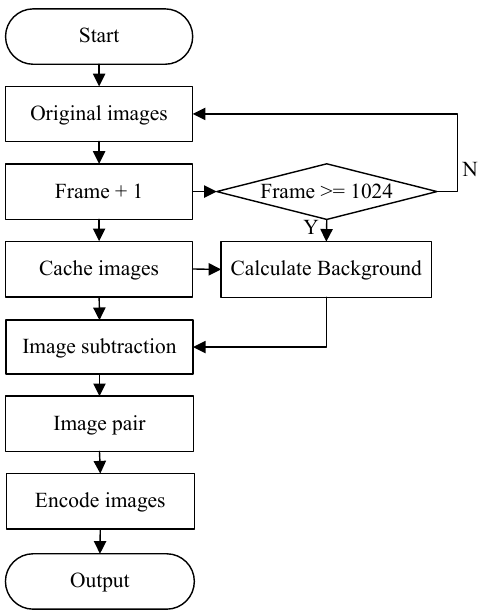
Figure 4. Flowchart of background removal, image detection, and encoding. 3